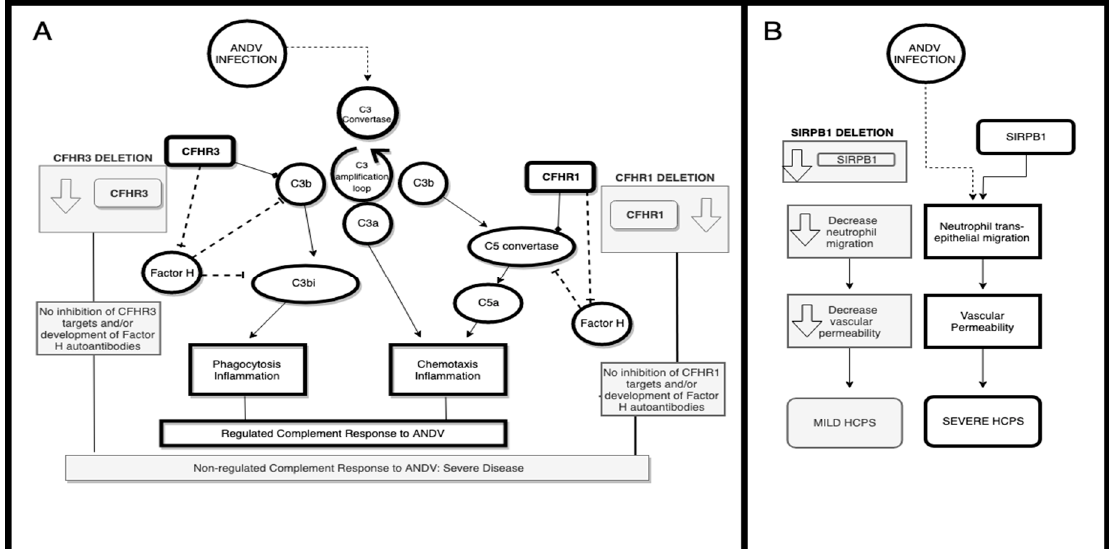
Figure 4. ( A ) model of CFHR1-3 participation in Andes orthohantavirus (ANDV) infection response. In white is the patient’s complement pathway response to ANDV infection. In grey is the proposed e ff ect caused by the CFHR genes’ deletion. ( B ) model of SIRPB1 in ANDV infection response. In white is the neutrophil response to ANDV infection. In grey is the proposed e ff ect caused by SIRPB1